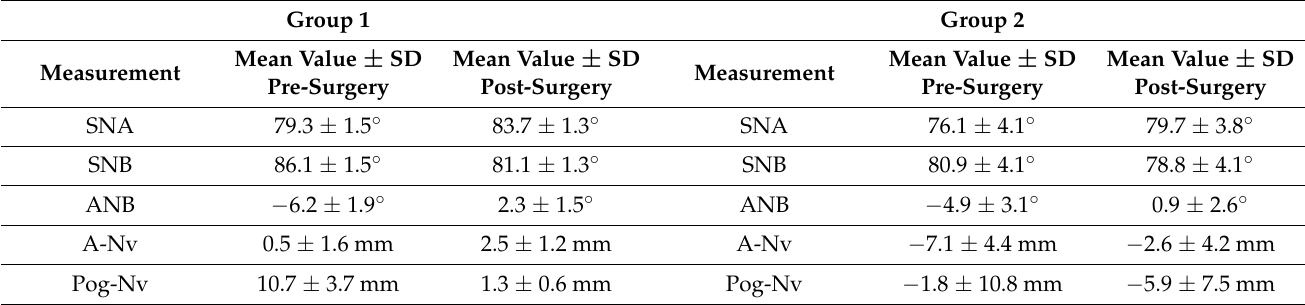
Table 2. Cephalometric measurements taken three weeks before surgery and 2~3 days after surgery.